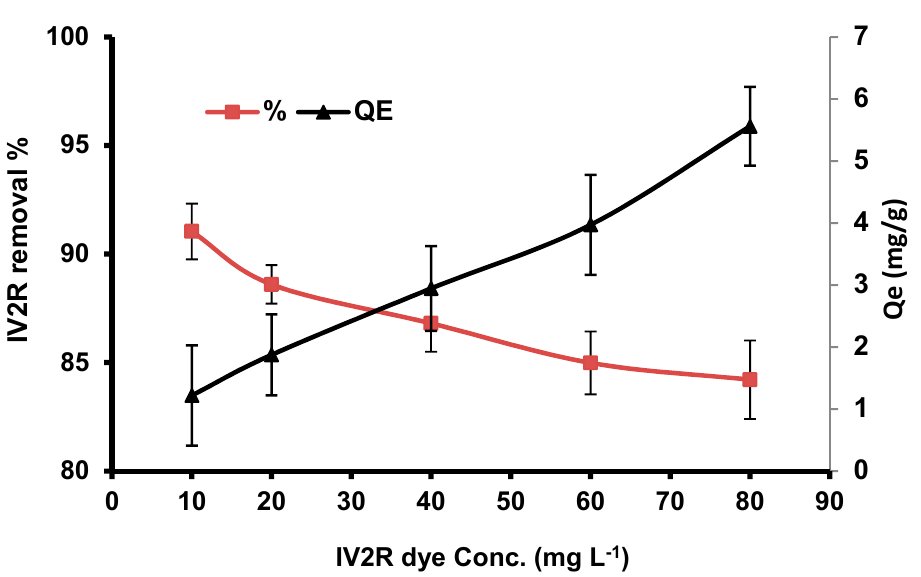
Figure 9. Influence of the initial IV2R dye concentration.